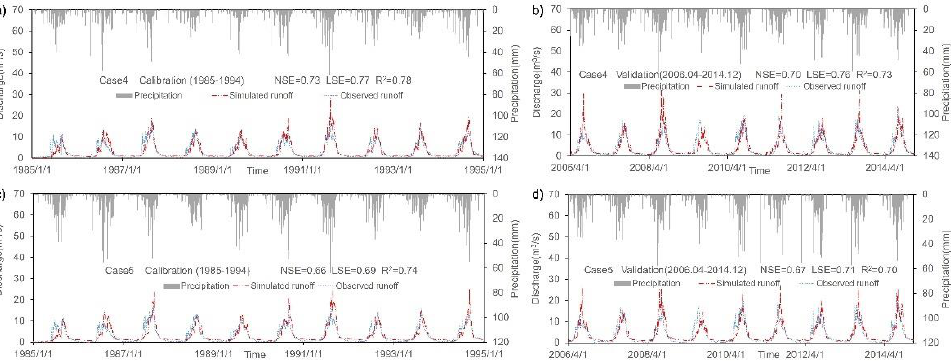
Figure 10. Comparison of daily runoff simulation results from the J2000 model using the traditional TLR scheme (Case 4, a and b) and the new TLR scheme (Case 5, c and d) for the periods of calibration (a and c) and validation (b and d), when the precipitation gradients were derived from station ob- servations.